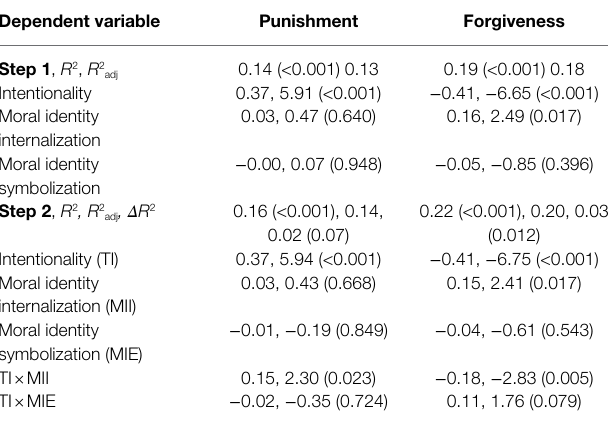
TABLE 2 | Regression results of Study 2.